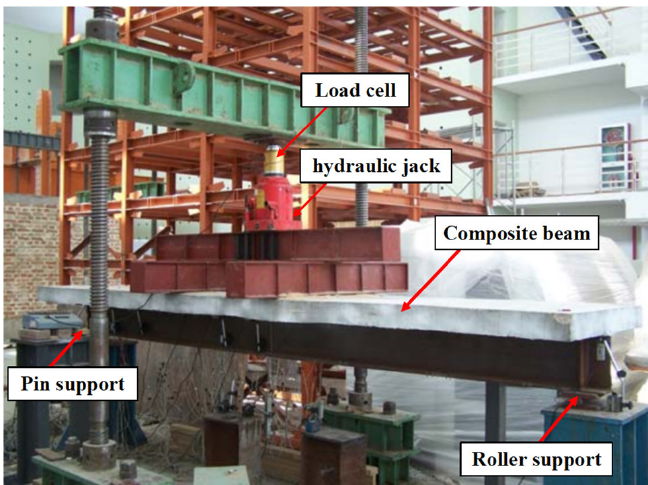
Figure 2. Bending test set-up.